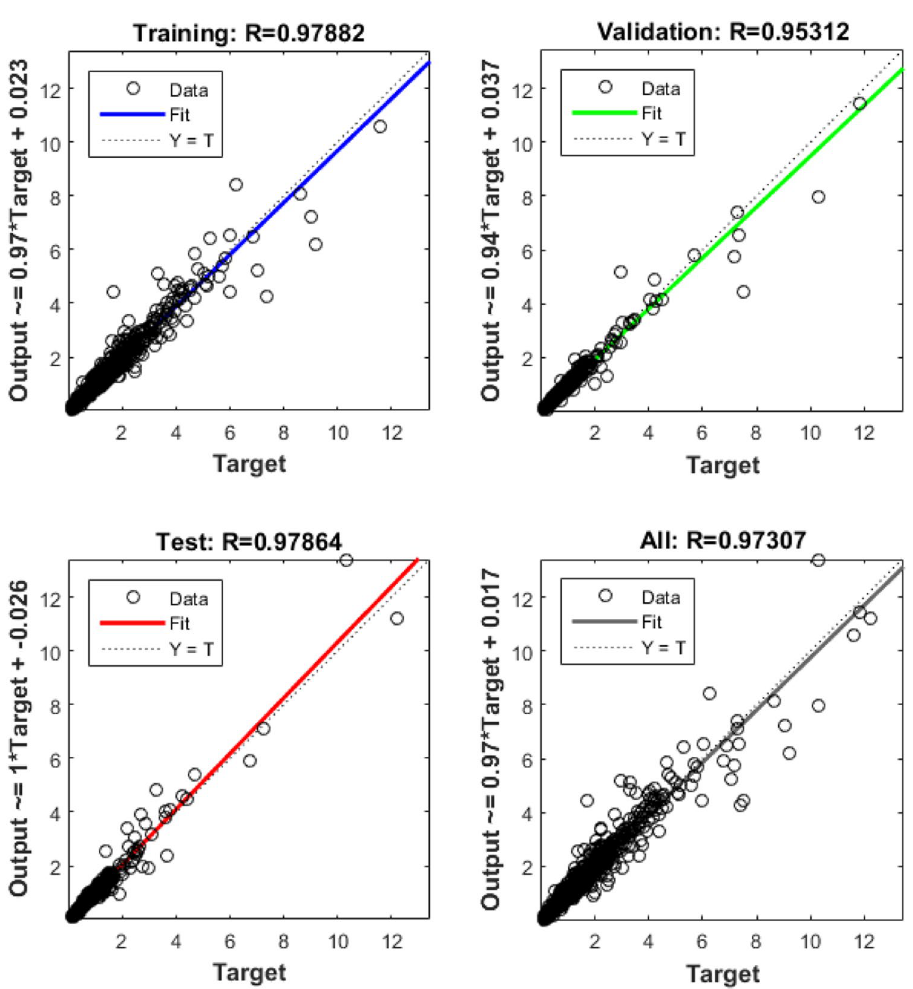
Fig. 15 MPL model validation of Field